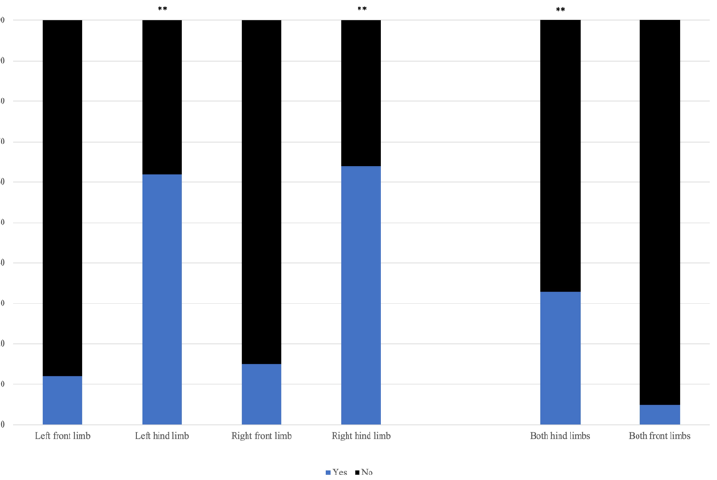
Figure 1. Distribution of occurrence of lameness in the front and hind limbs in animals diagnosed with left displaced abomasum and claw diseases (LDA + CLAW). Occurrence of claw lesions is given as ‘yes’ (blue) and ‘no’ (black). Significant differences of >0.01 are presented as **. Hind limbs were affected significantly more often than front limbs. In 33.3% of animals ( n = 33), claw lesions were found in both hind limbs.